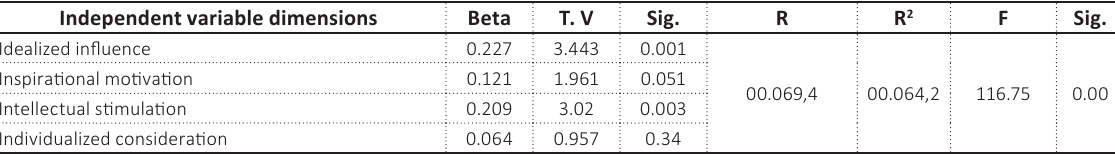
Table 7. Relationship between empowerment and job satisfaction Mediator